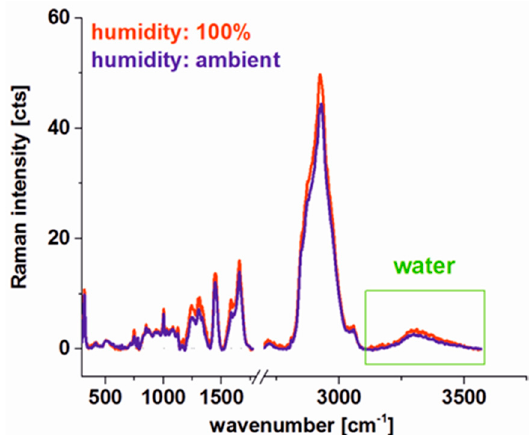
Figure 6. Comparison of Raman spectra for human colon cancerous tissue for 100% and 23% (ambient) humidity conditions.